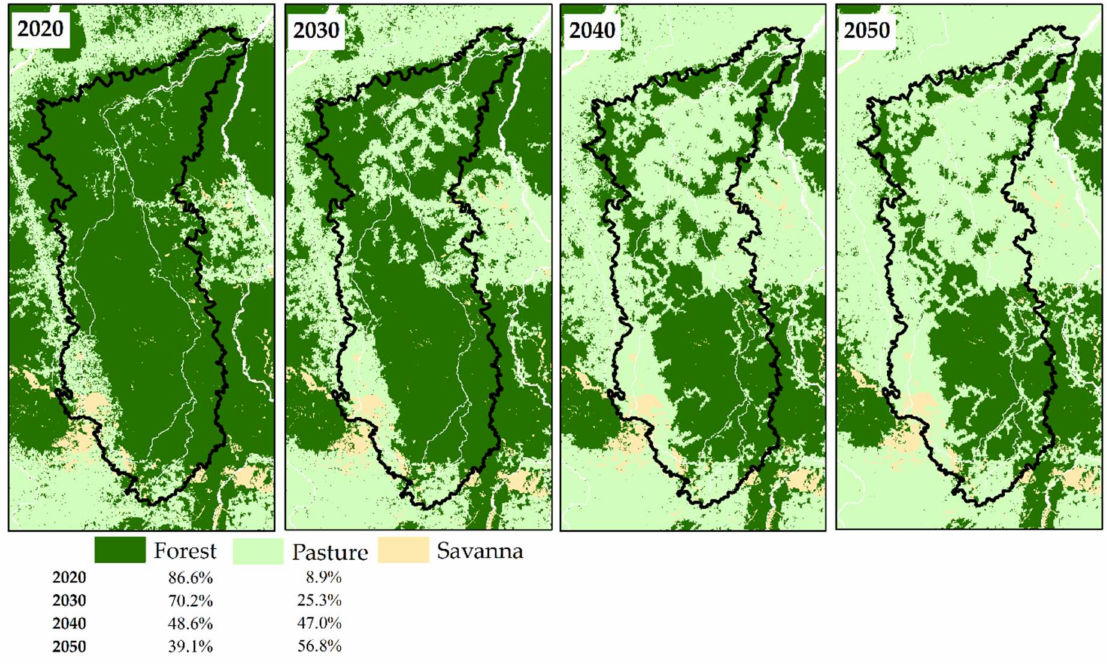
Figure 3. ‘Business-as-usual’ scenario for 2020, 2030, 2040, and 2050 in Iriri River Basin